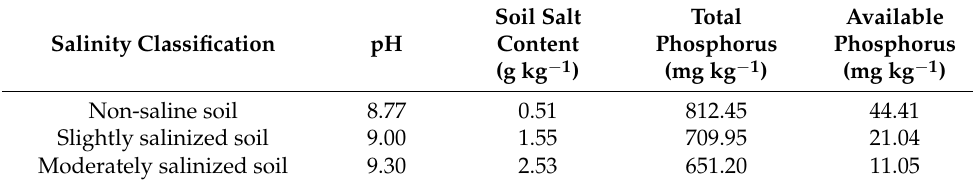
Table 1. Main properties of the survey